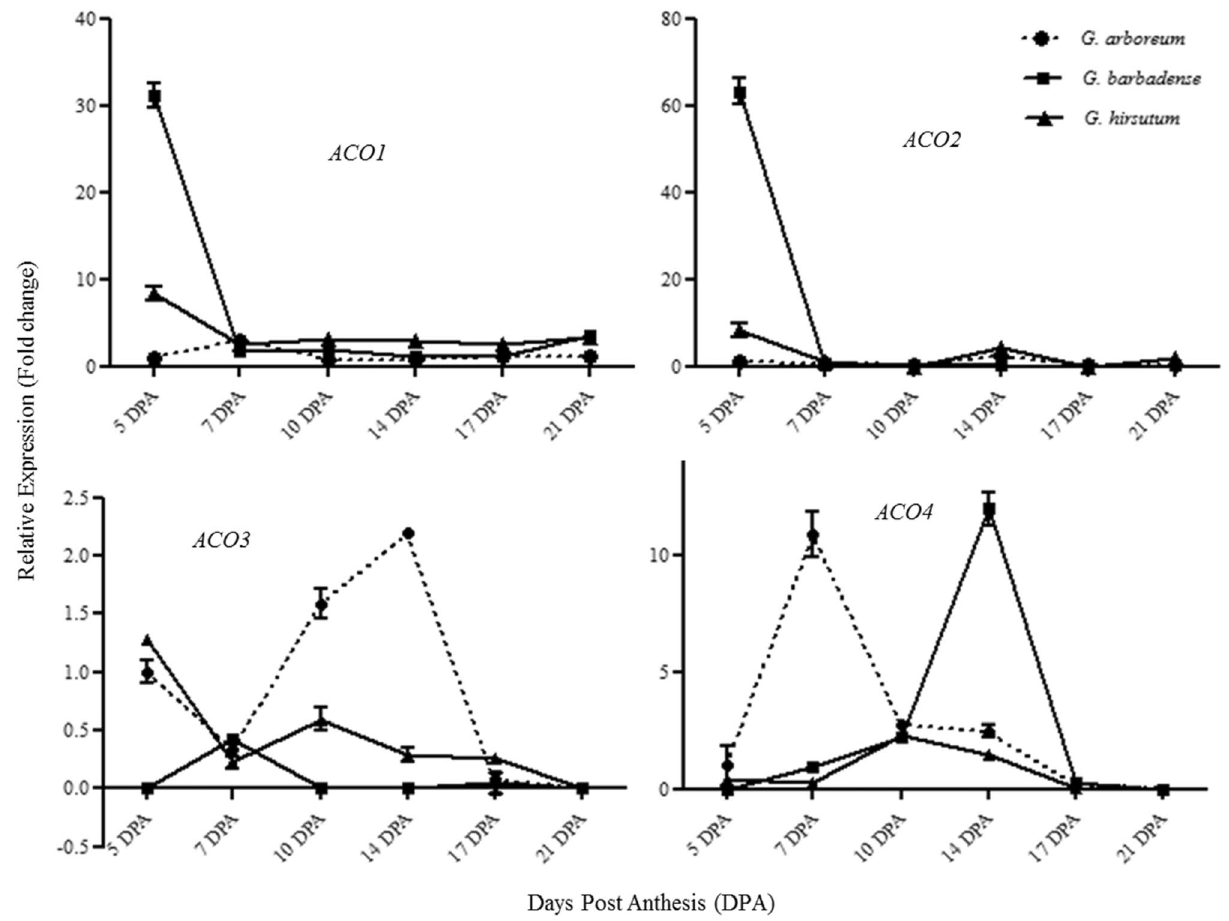
Figure 6. Transcription abundance of ACO isoforms in developing fibers of Gossypium